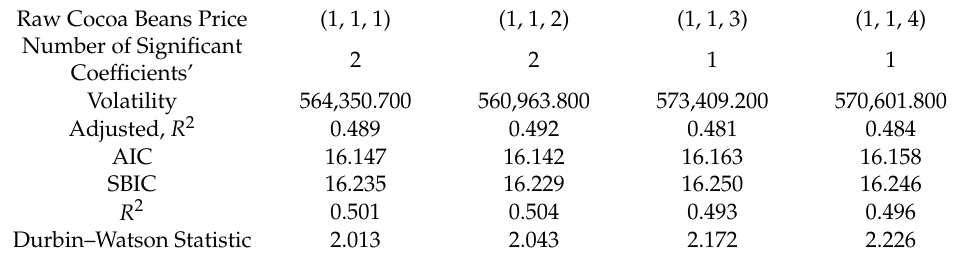
Table 6. Summary of ARIMA estimation output for Raw Wet Cocoa Beans Price